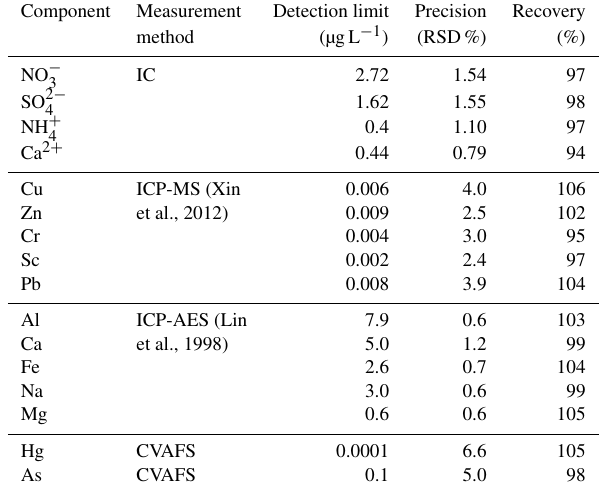
Figure 1. Location of the aerosol and dust sampling sites.